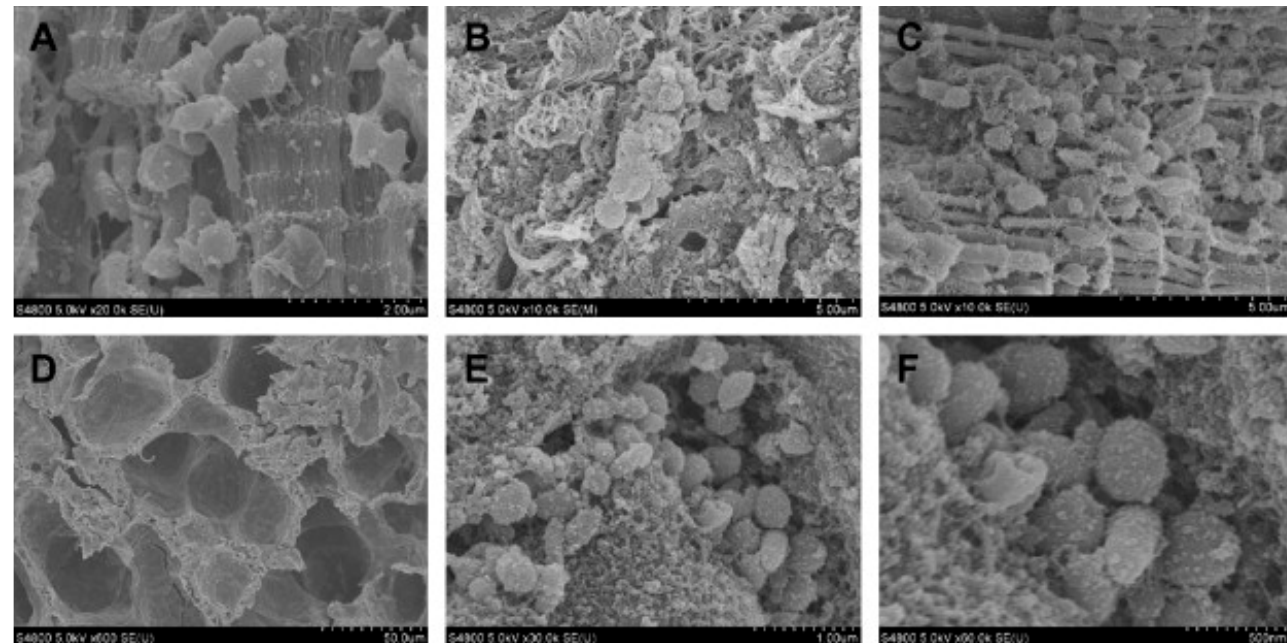
Figure 6. Scanning electron microscopy of freeze-fractured samples of cardiac (see chapter 3) and lung tissues. Top panel: ( A ) Scanning electron microscopy images of normal cardiac tissue; ( B , C ) infected cardiac tissue containing coccus-shaped bacteria surrounded in a matrix network. Scale bars: ( A ) 2 μ m with magnification 20,000×; ( B , C ) 5 μ m with magnification 10,000×. Bottom panel: ( D ) normal lung tissue; ( E , F ) infected lung tissue containing few coccobacilli within an extracellular matrix. Scale bars: ( E ) 1 μ m with magnification 30,000×; ( F ) 0.5 μ m with magnification 60,000×. Reprinted from [21], Copyright (2009), with permission from Elsevier.